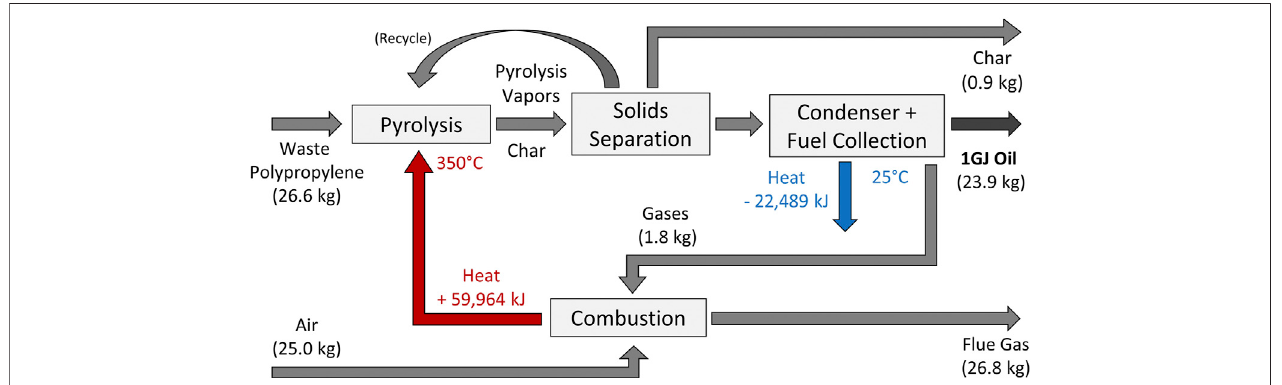
FIGURE 2 | Schematic representation of material and energy balances of the PP pyrolysis process. A possible recycling structure is indicated but not utilized in this work.